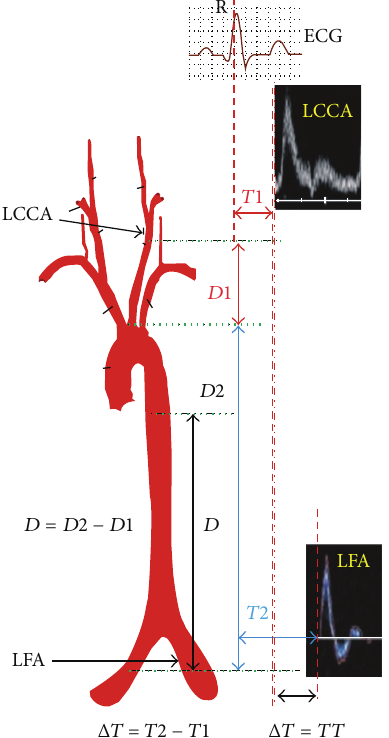
Figure 1: PWV estimation: time diversity of electrocardiographic and carotid-femoral Doppler signal. 𝑇𝑇(Δ𝑇) : time delay, LCCA: left common carotid artery, LFA: left femoral artery, and Δ𝑇 : time